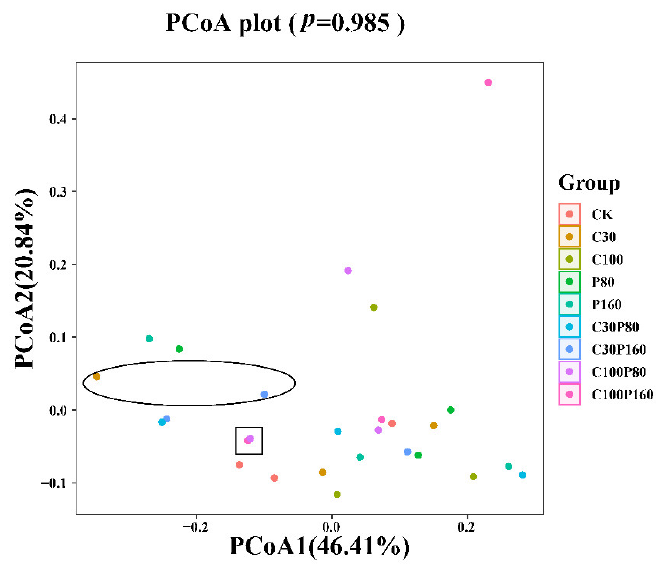
Figure 4. PCoA analysis reflecting the relationship between samples.